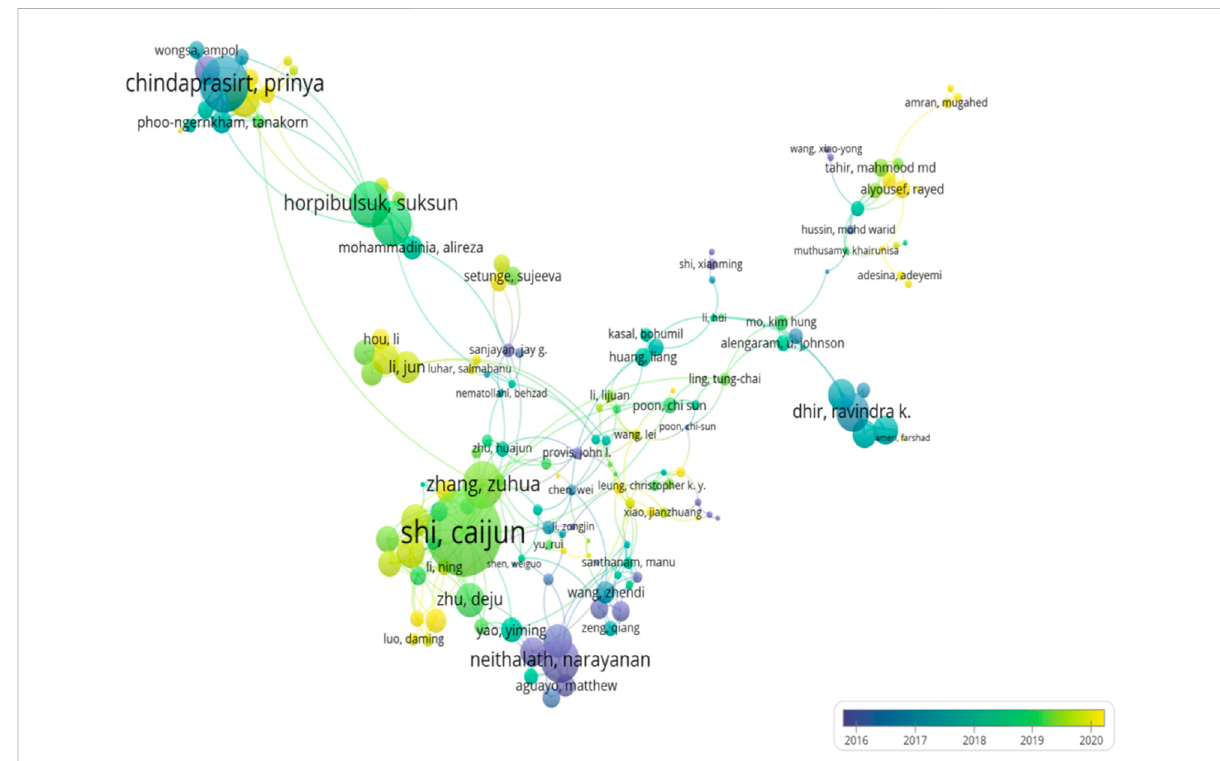
FIGURE 5 Collaborative network mapping of research authors in the fi eld of ecological concrete